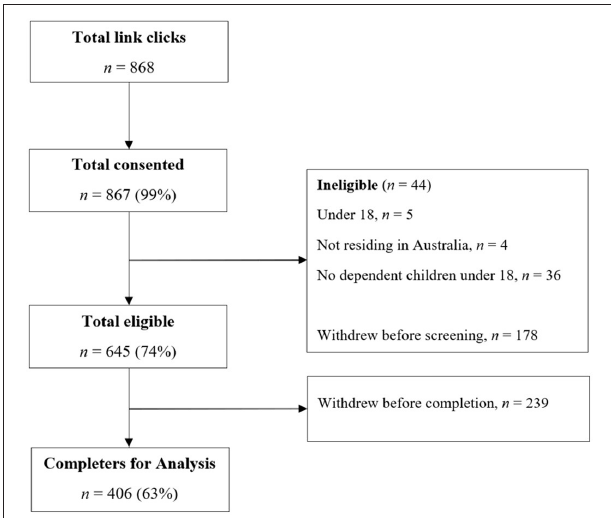
FIGURE 1 | Flowchart of participant